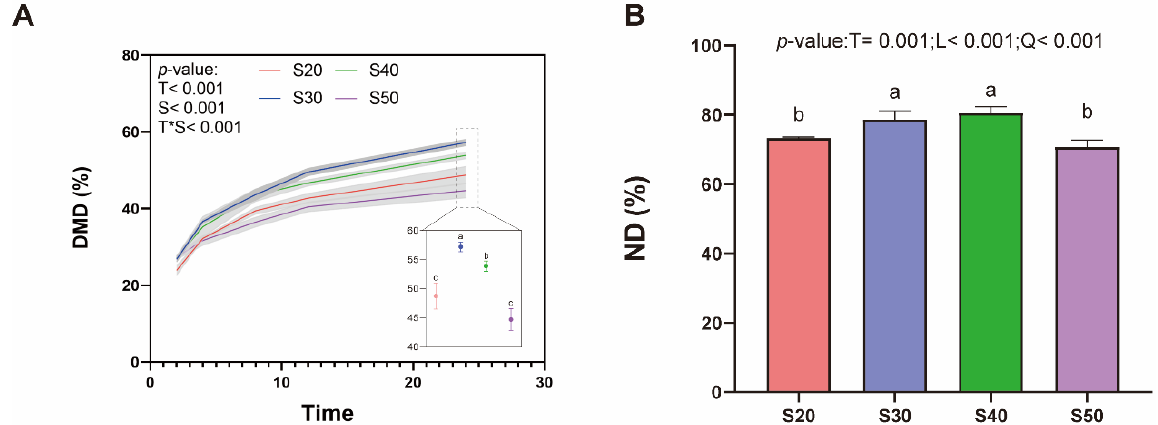
Figure 1. Substrate digestibility under different SP treatments (n = 6). ( A ) Substrate dry matter di- gestibility (DMD) changes at different sampling times, different letters indicate significant differences among SP treatments at p < 0.05. T: treatment; S: sampling time; T × S: interaction between T and S. ( B ) Substrate nitrogen digestibility (ND) at 24 h of culture. Bar charts with different letters indicate a significant difference at p < 0.05. Treatments: S20, S30, S40 and S50 are ~14% CP, SP proportion (% of CP) 20, 30, 40 and 50, respectively. T: treatment; L: linear; Q: quadratic.